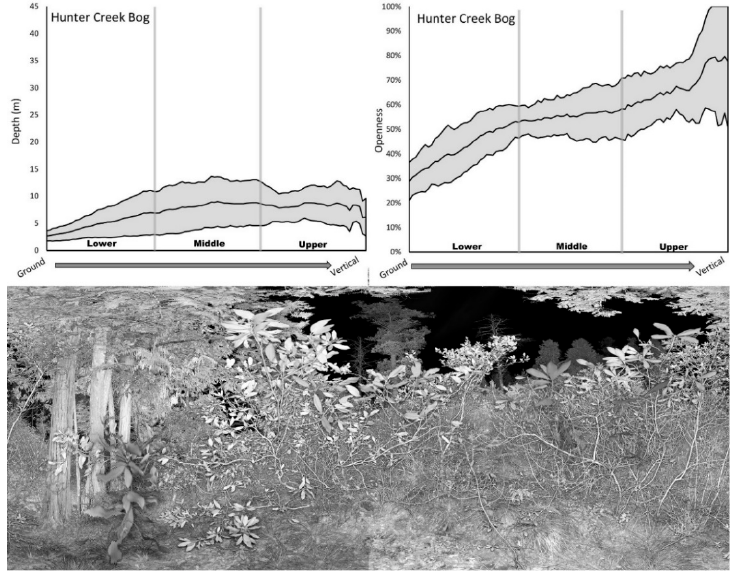
Figure 5. Structural signatures (shaded area is one standard deviation above and below mean) and representative photo of Limpy Rock RNA ( above ) and Hunter Creek Bog ACEC ( below ). Some stands had increasing structural variation from the ground to the canopy (e.g.,